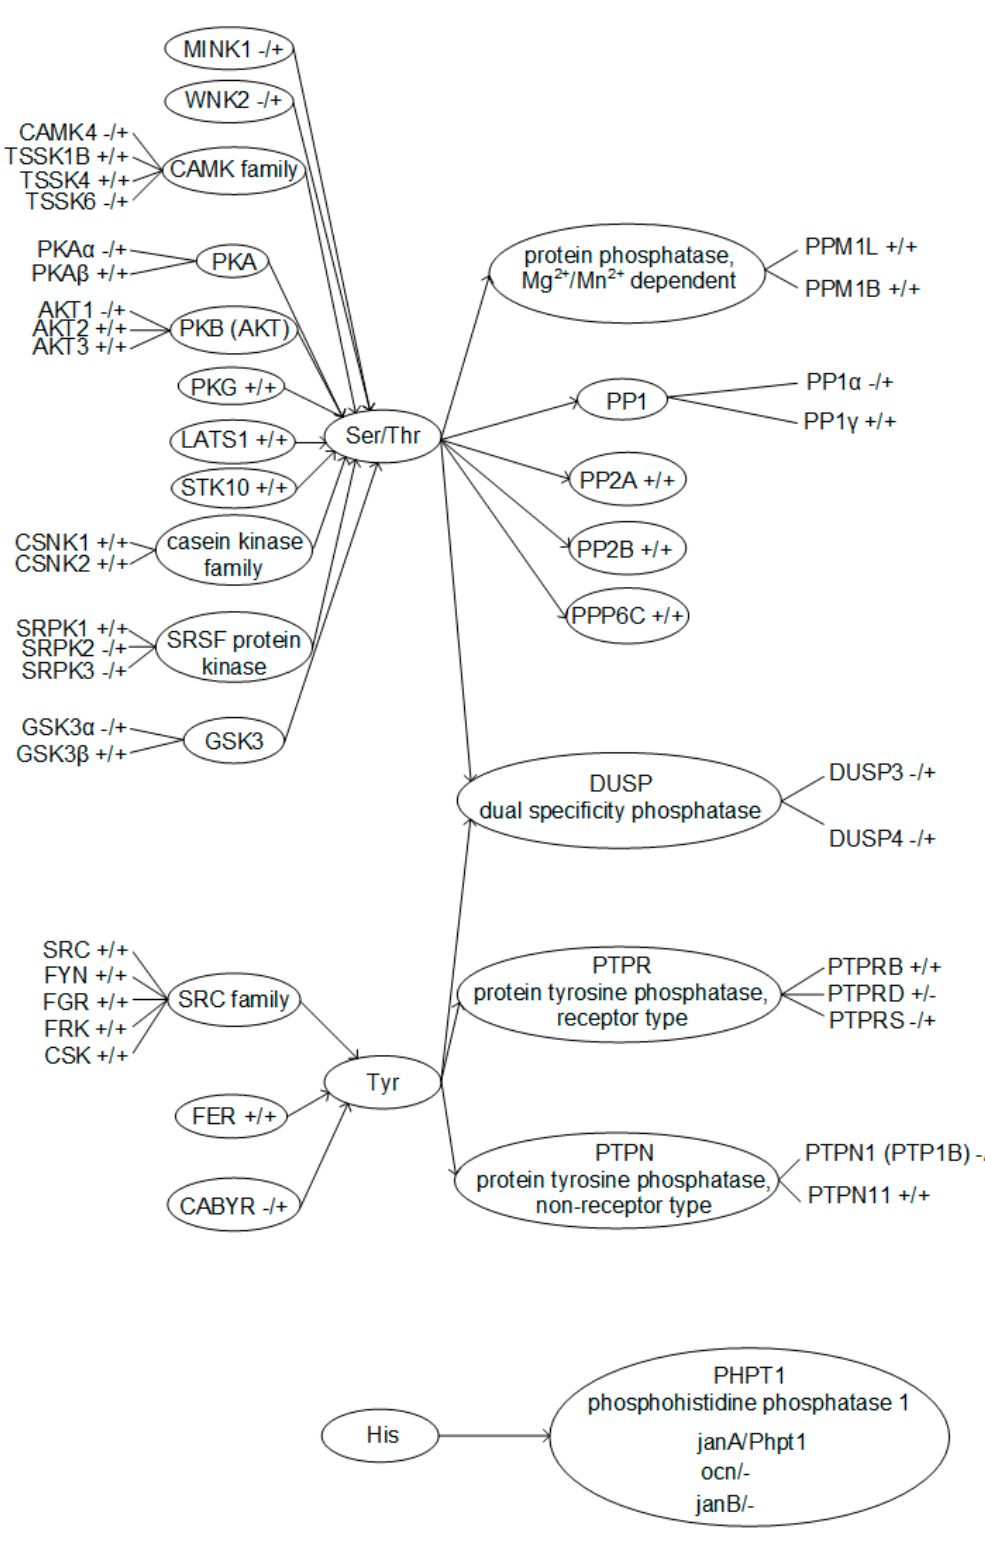
Figure 5. Phosphorylated amino acids residues with according kinases and phosphatases, identified in Drosophila melanogaster and mouse sperm. +/+ means existence of the protein in the Drosophila melanogaster/mouse genome,